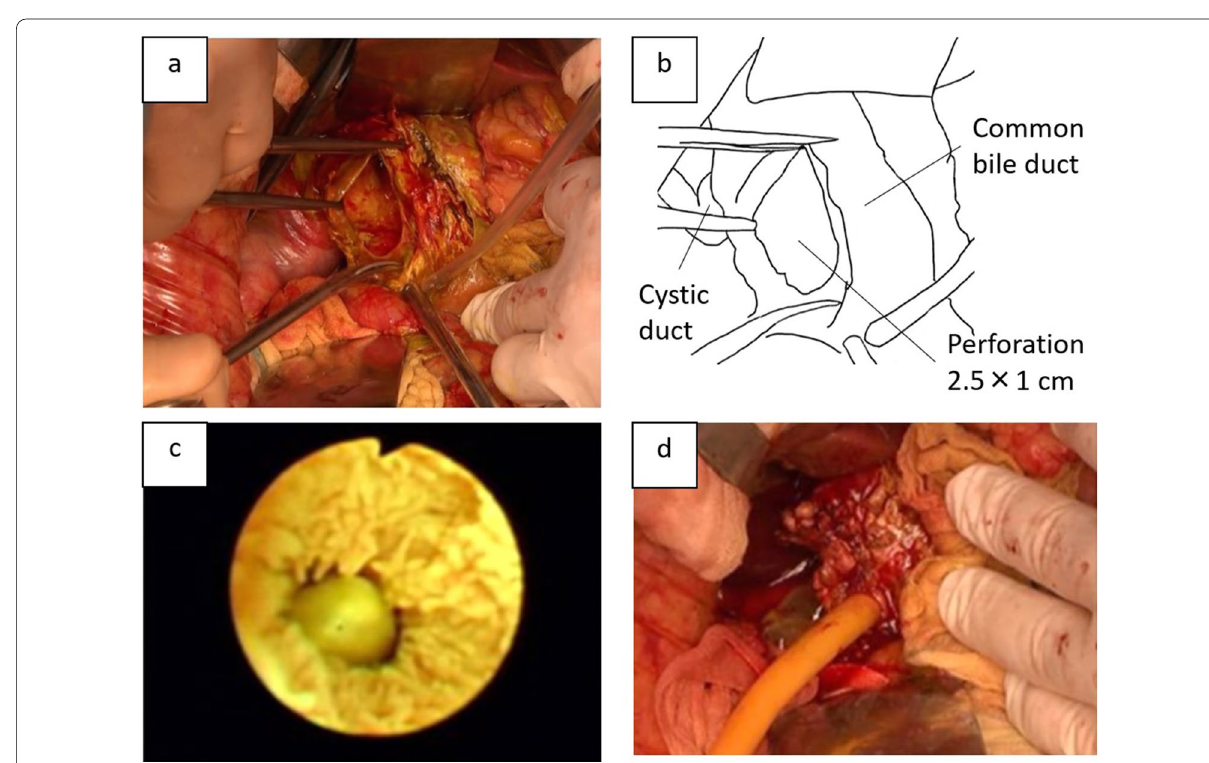
Fig.3 Operative findings. Intraoperative findings revealed that a necrotic diverticulum-like change with bile leakage was present on the supraduodenal part. After removing the necrotic lesion, we found a single 2.5 1 cm perforation on the anterolateral wall of the common bile duct × ( a ). The above findings are shown in the schema ( b ). Intraoperative cholangioscopy revealed an impacted stone in the major duodenal papilla ( c ). A T-tube was inserted through the perforation ( d